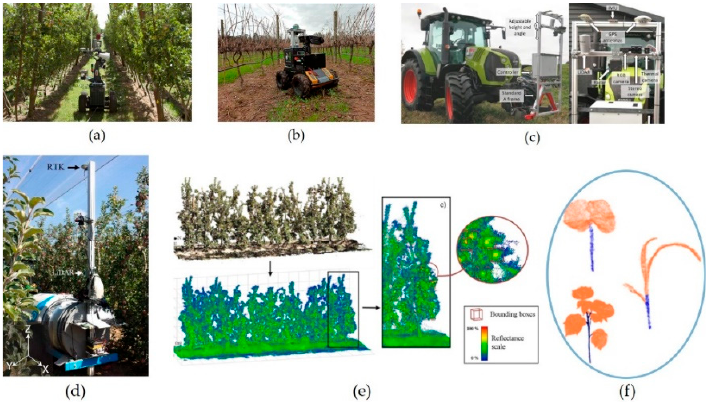
Figure 1. Examples of LiDAR applications in agricultural environments: ( a ) shrimp robot platform [20]; ( b ) AgRob V16 platform [15]; ( c ) tractor platform [19]; ( d ) acquisition of orchard canopy parameters [34]; ( e ) identifies and estimates apple production [12]; ( f ) plant organ division [35] .